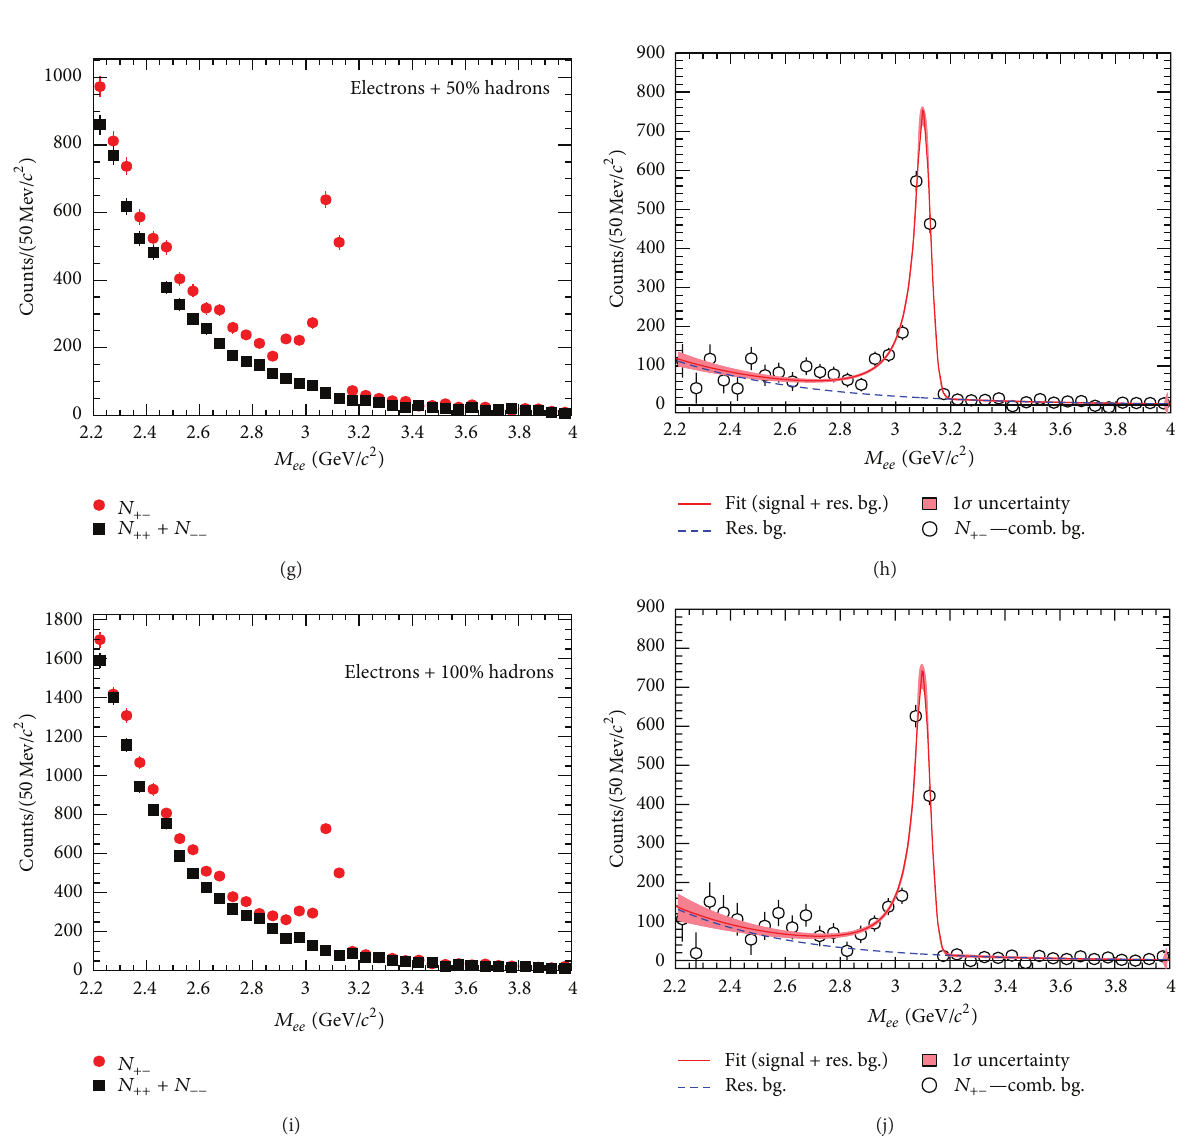
Figure 7: Dielectron mass spectra and 𝐽/𝜓 signals for various hadron contamination levels.